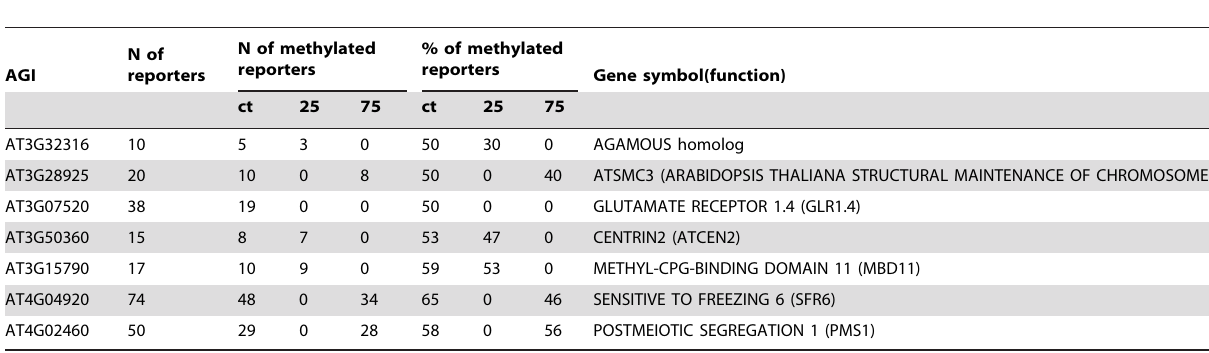
Table 4. Genes hypomethylated in the progeny of stressed plants.